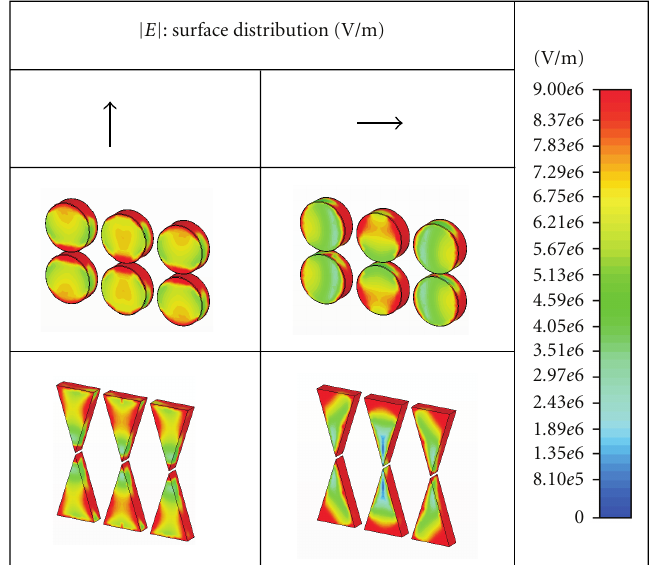
Figure 8: Absolute value of the field distribution for 3-element arrays of both disc dimers and bowties ( r = 40nm, gap = 5nm) when the dipolar field is oriented along or perpendicular to the alignment axis of the dimers. The field is generated by a dipole with length 5nm and current